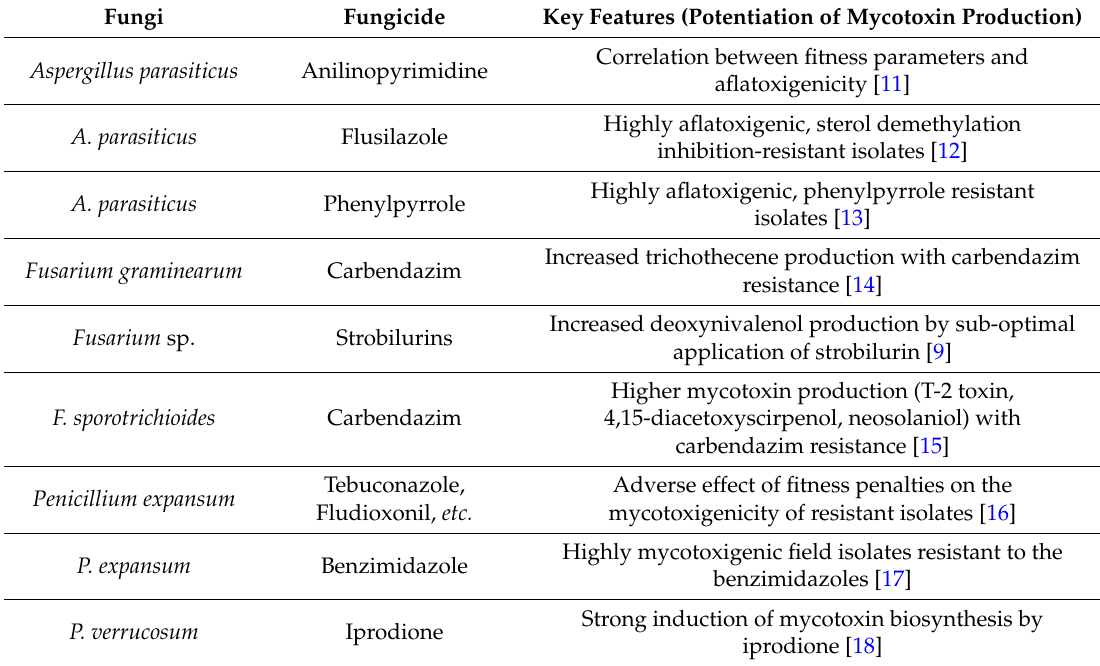
Table 1. Fungicide potentiation of mycotoxin production in fungal pathogens. Fungi Fungicide Key Features (Potentiation of Mycotoxin